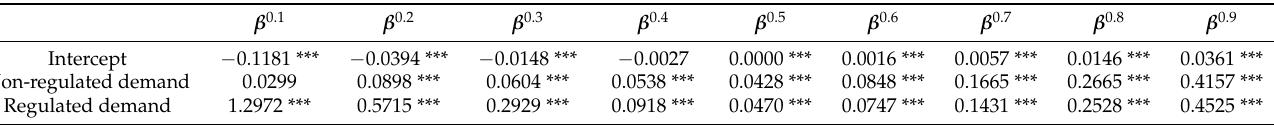
Table A4. Quantile regression coefficients for the threshold levels (0.05, 0.85) in 2020.